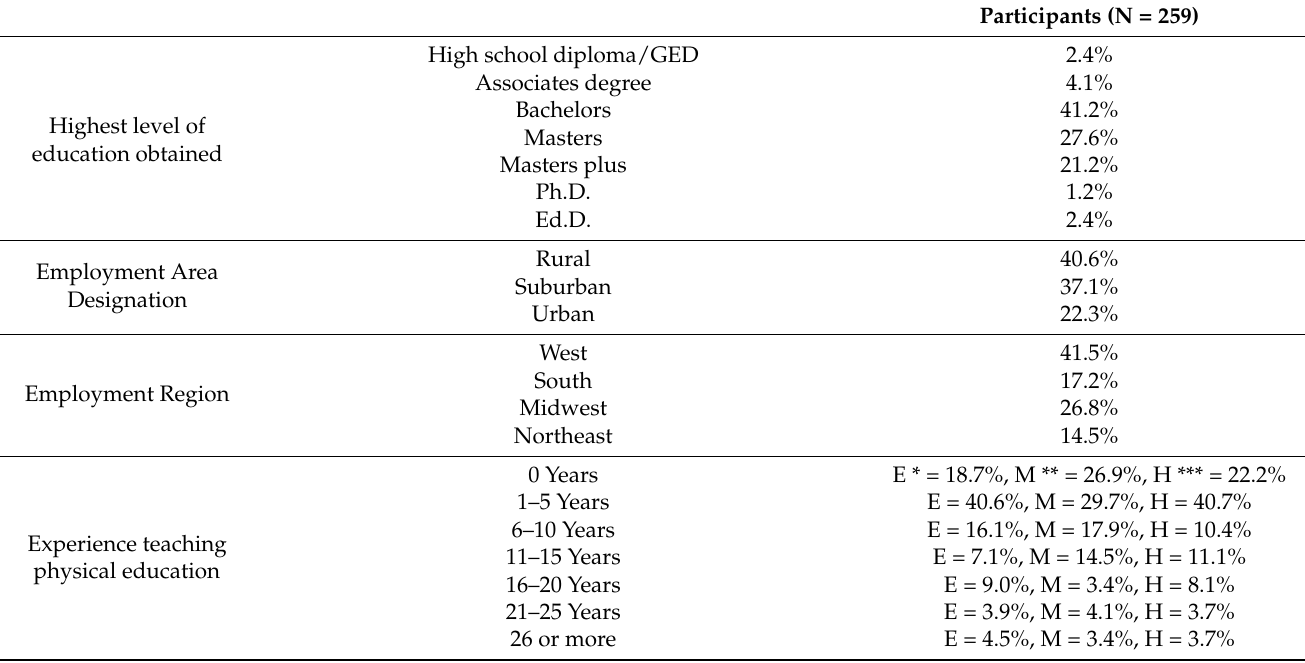
Table 1. Participants’ self-reported demographics and school